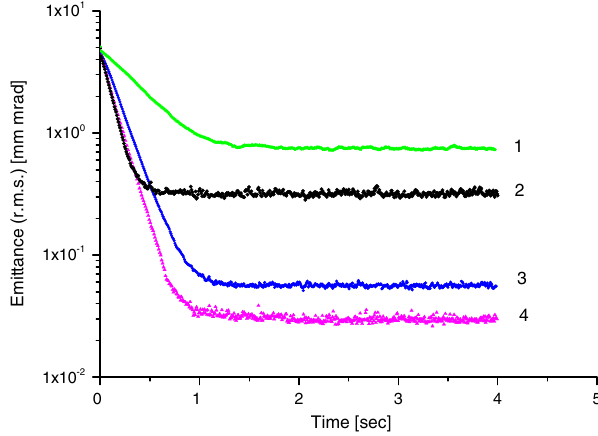
FIG. 16. Ion kinetics of a high-intensity antiproton beam ¼ 2 (cid:6) 10 7 ): (a) evolution of 20 keV antiprotons cooled by ( N 0 (1) thermocathode e -gun to equilibrium emittance " eq x ¼ 0 : 73 (cid:4) mm mrad (rms) and cooled by (2) photocathode to equi- librium at " eq x ¼ 0 : 35 (cid:4) mm mrad (rms). Ions at 300 keV cooled by (3) thermocathode to equilibrium emittance " eq x ¼ 0 : 055 (cid:4) mm mrad (rms) and cooled by (4) photocathode to equilibrium at " eq x ¼ 0 : 04 (cid:4) mm mrad cooled at 300 and 20 keV is shown in Fig. 16. thermocathode gun and (2) for the photocathode gun.